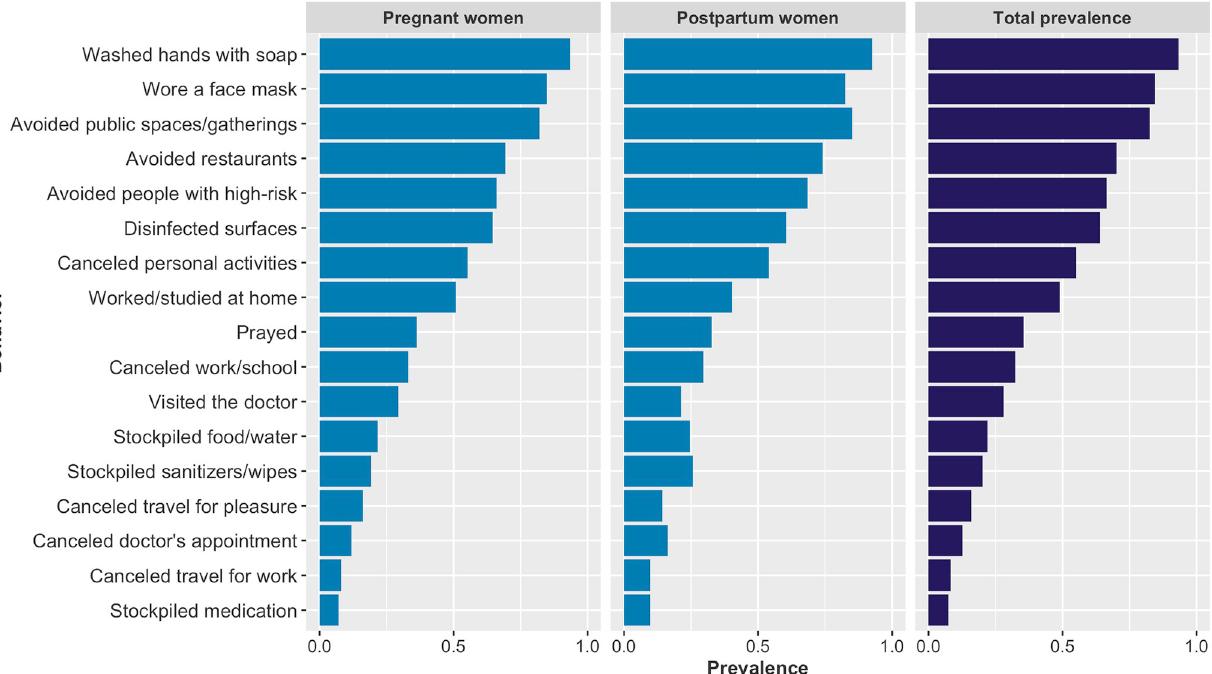
PLOS ONE | https://doi.org/10.1371/journal.pone.0249780 April 21,